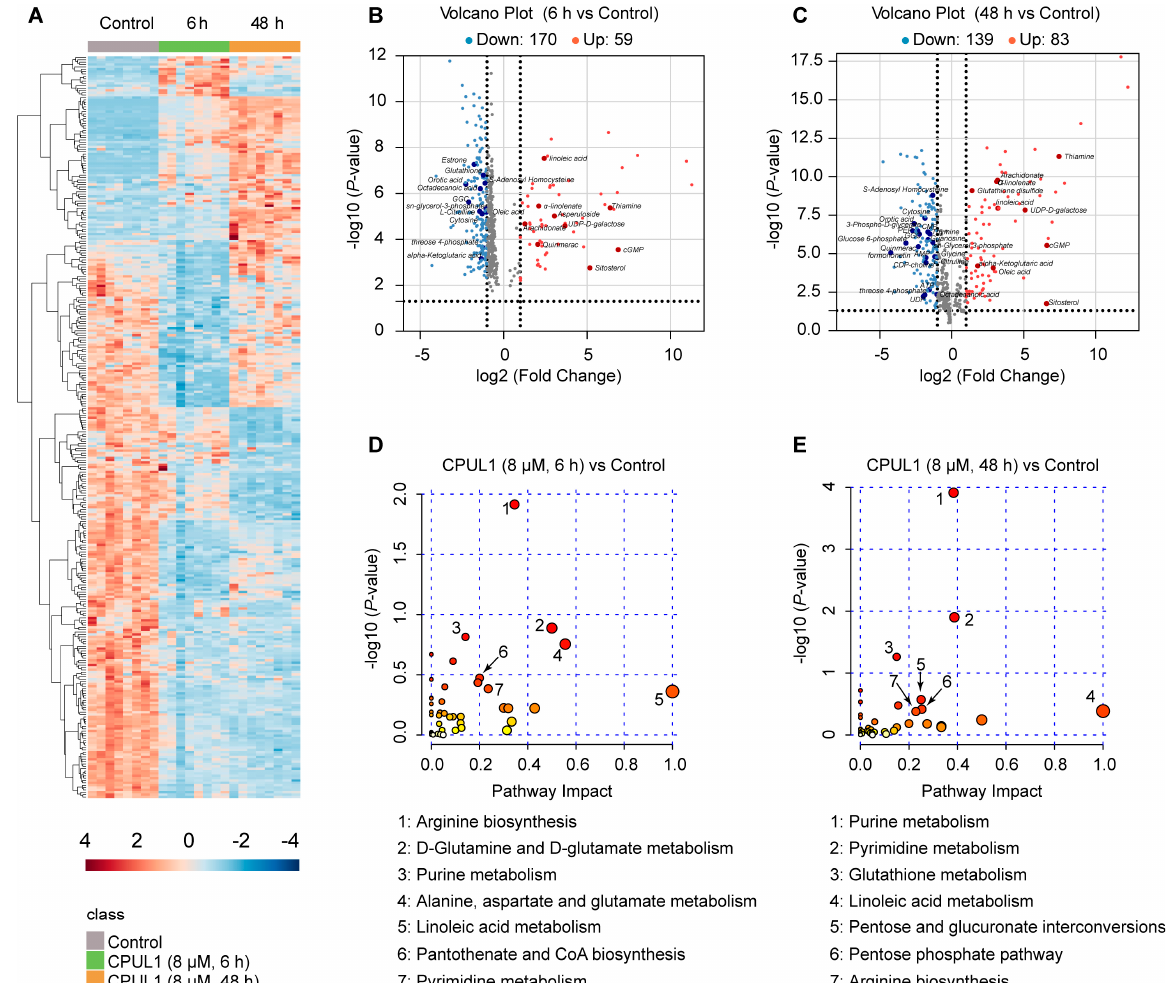
Figure 5. The effects of CPUL1 on the metabolic pathways of the BEL-7402 cells pretreated with 8 µ M CPUL1 for 6 h and 48 h. ( A ) The cluster heatmap of the most significantly differential abundance metabolites (DAMs) identified for CPUL1 treatments and control, and the blue to the red color scale indicated the value of DAM expression after the scale number. ( B , C ) Volcano diagram of the DAMs between 6 h- and 48 h-CPUL1-treated BEL-7402 cells and control cells (n = 8). The y-axis corresponds to the expression value of − log10 ( p -value), and the x -axis displays the log2 (FC) value. Red dots indicate upregulated genes, blue dots indicate downregulated genes, and black ones represent the genes without statistical significance. ( D ) Metabolome view of the pathway analysis generated using MetaboAnalyst 5.0 based on DAMs in the untreated and 6 h-CPUL1-treated cells. ( E ) Metabolome view of the pathway analysis generated using MetaboAnalyst 5.0 based on DAMs in the untreated and 48 h-CPUL1-treated cells.